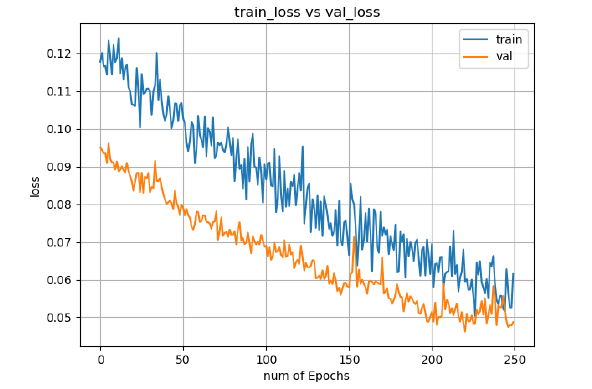
Figure 5. CNN | 1 Scratch (having a shallow Convolutional Neural Networks (CNN) architecture with proper maxpooling) achieves a high validation accuracy of 98.84%. The lower figure shows that both validation and training loss converged near the 250th epoch. The corresponding validation and training accuracy curve is shown in the upper figure.